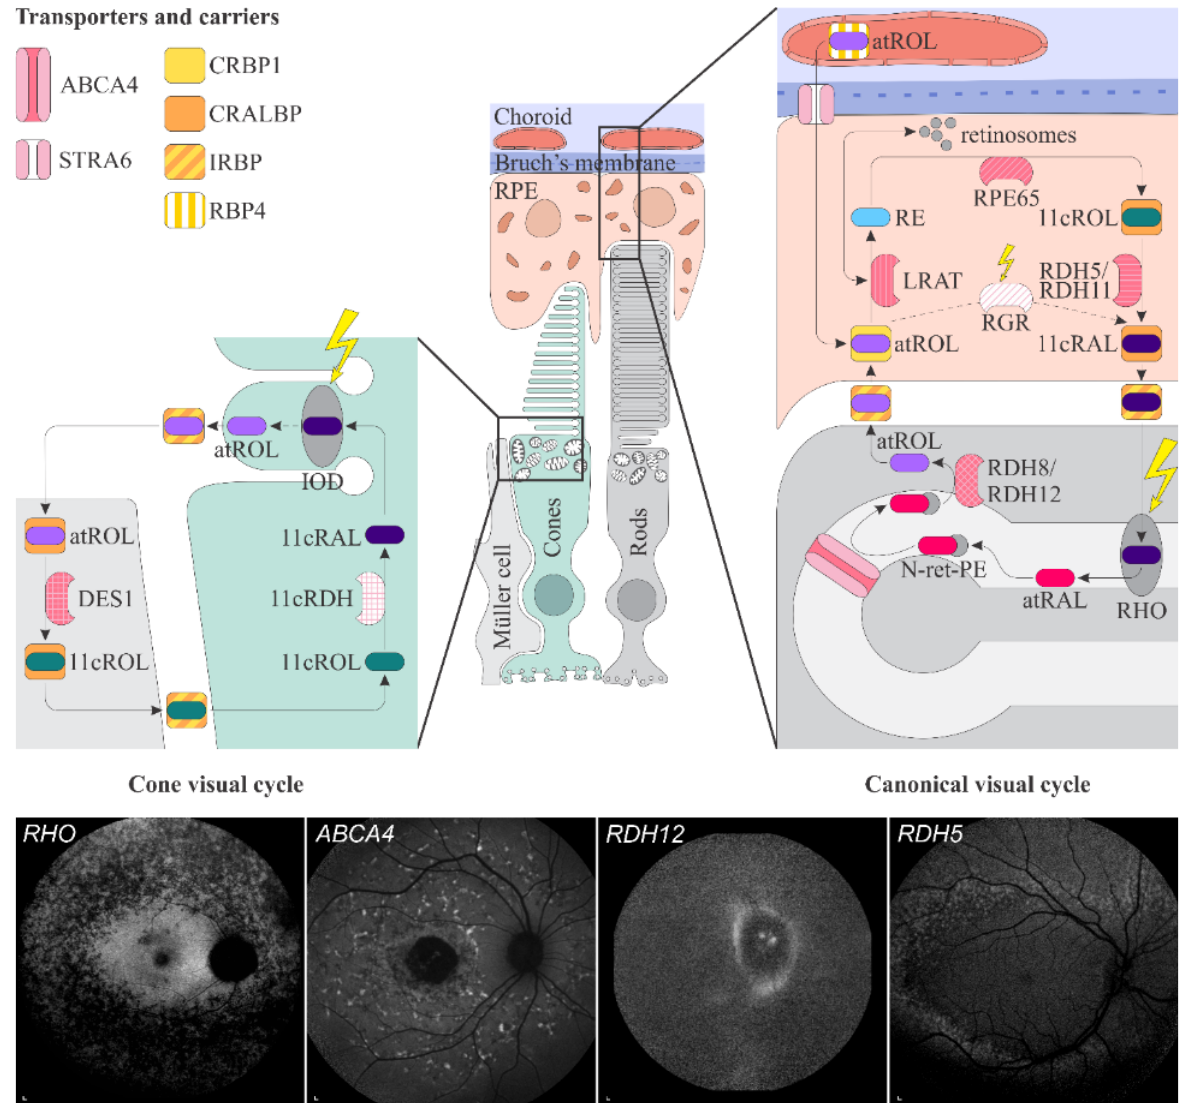
Figure 1. Schematic representation of the canonical and cone visual cycles. Key enzymes, transporters, carriers and retinoids are shown. Fundus autofluorescence (FAF) images of representative patients, harbouring pathogenic variants in genes, encoding four essential proteins involved in the visual cycle, are presented below. Scale bars for four FAF images: 200 μ m. Abbreviation expanation: